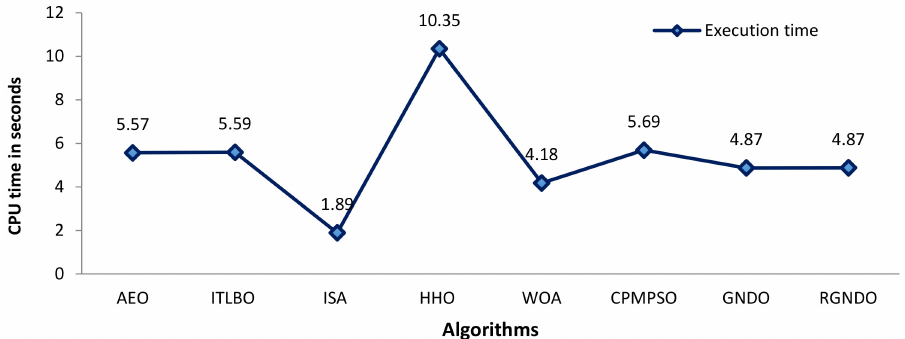
Figure 9. CPU time required by each algorithm.